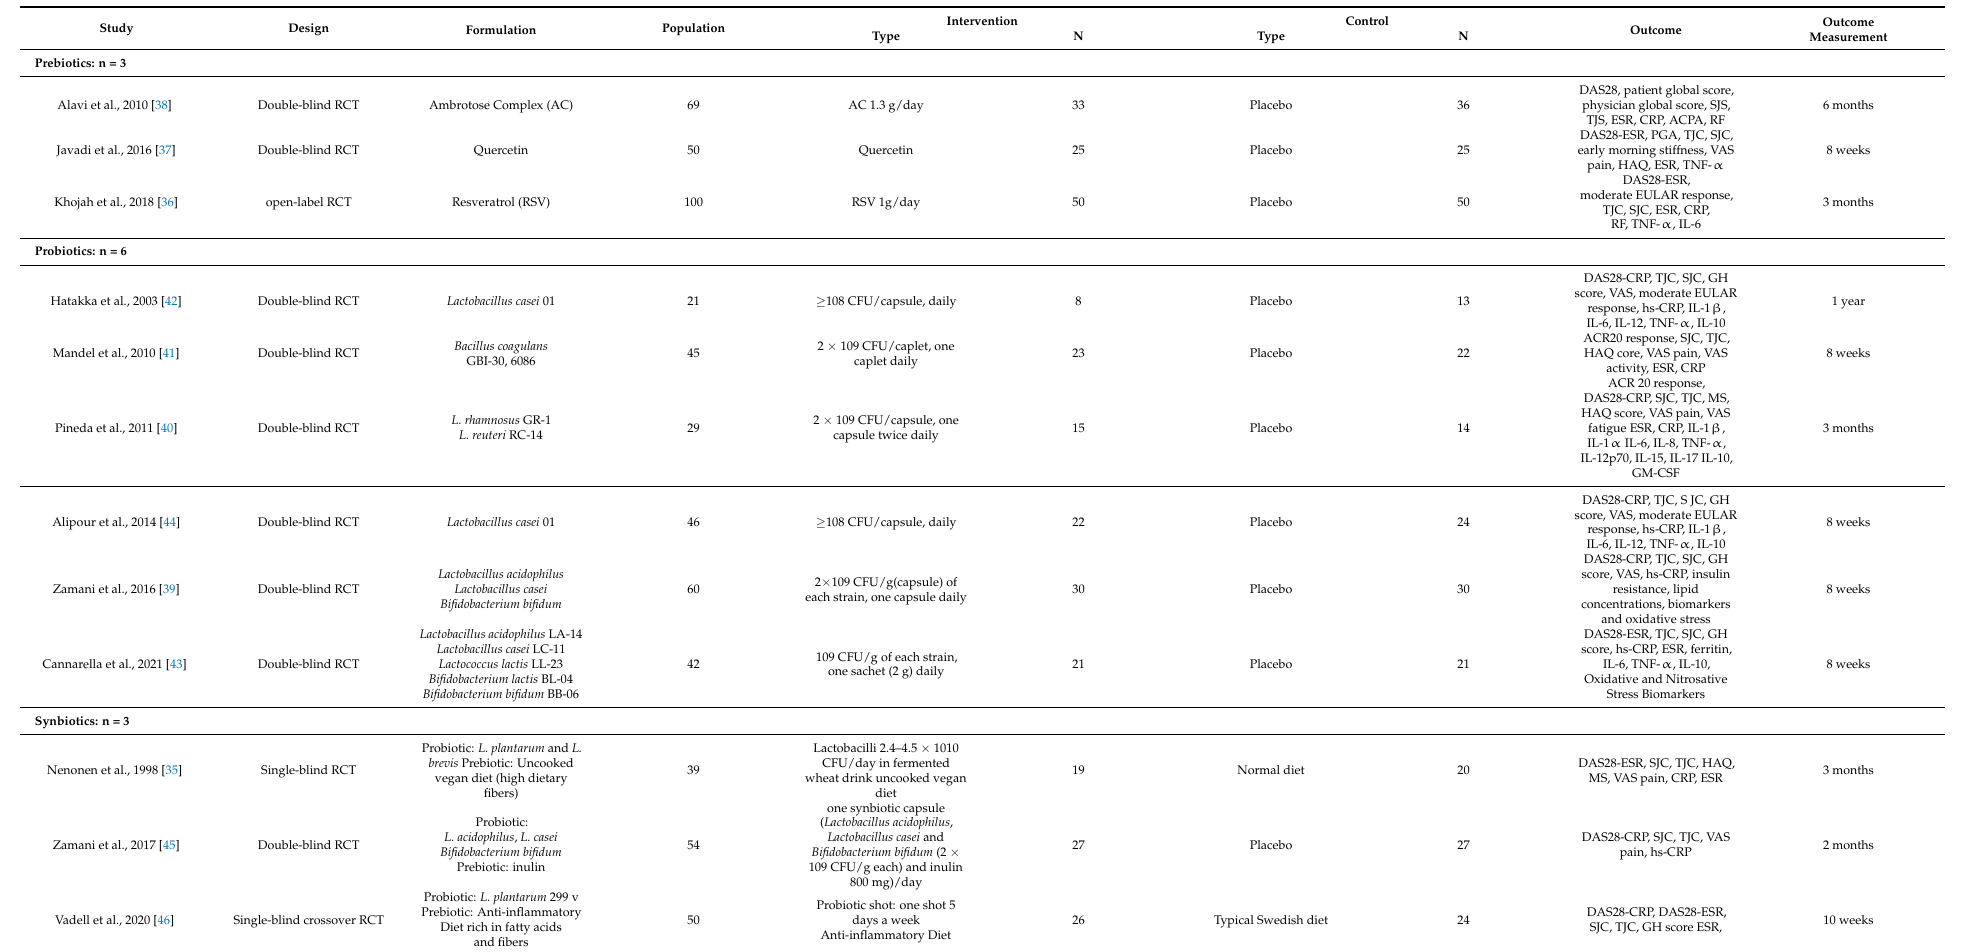
Table 2. Study characteristics of the 12 studies included in the systematic review sorted by microecological regulators